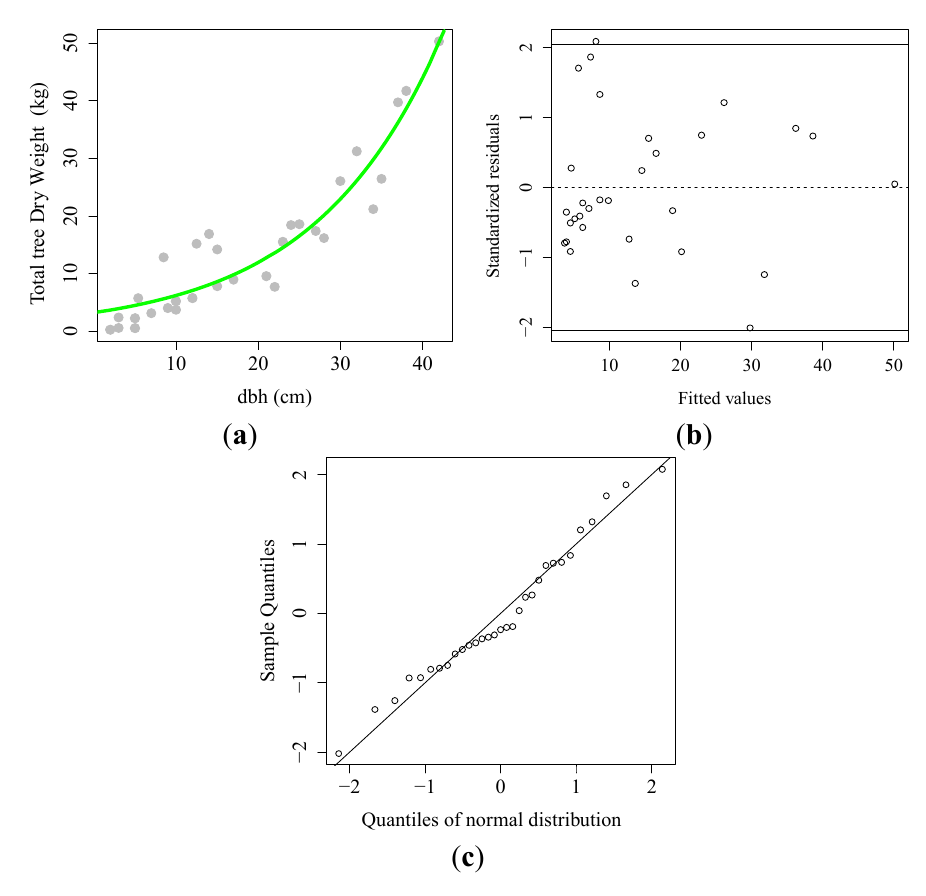
Figure 2. Evaluation of the adequacy of the model: ( A ) Relationship between tree dry weight (kg) against diameter at breast height (cm): (  ) observed; ( — ) fitted line; ( B ) Scatter plot of the standardized residual against predicted dry weight; ( C ) Normal Quantile–Quantile